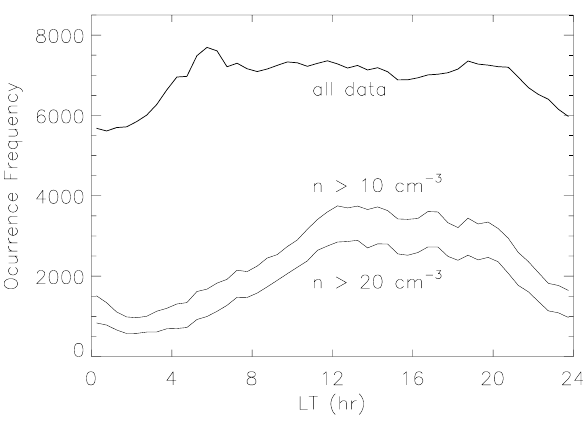
Fig. 2. Occurrence frequency (per half hour bin) of density mea- surements as a function of local time. The thick line includes all measurements of the 117 satellite data sets, while the thin lines ex- clude the low-density